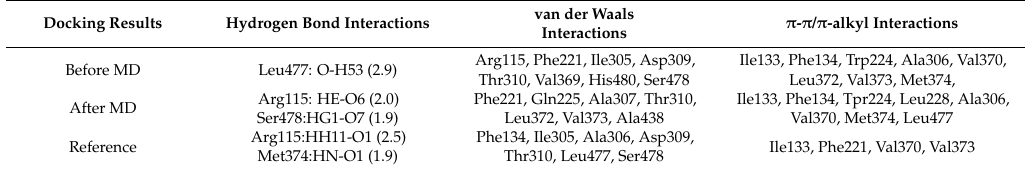
Table 2. Comprehensive intermolecular